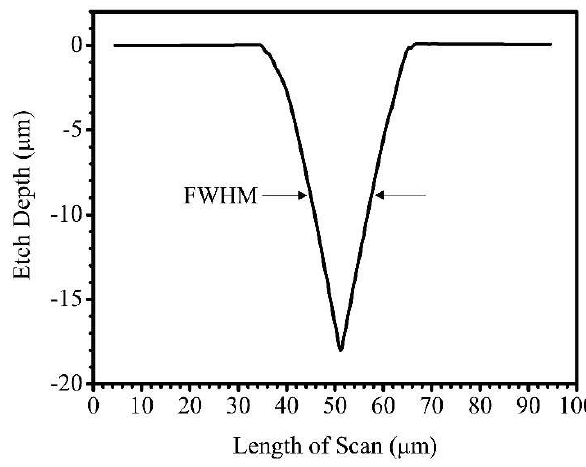
Figure 2. Line profile scan across 4 mm-length line feature machined into borosilicate glass using FLMP at PS CNC of 0.25 mm / s and 0.617 mJ power. The profile was recorded at 2 µ m / s, 10 Hz, and 2 mg applied force. The full-width at half-maximum (FWHM) value of 12.3 µ m of the Gaussian-like etched profile was determined as the spot size of the focused laser beam diameter.